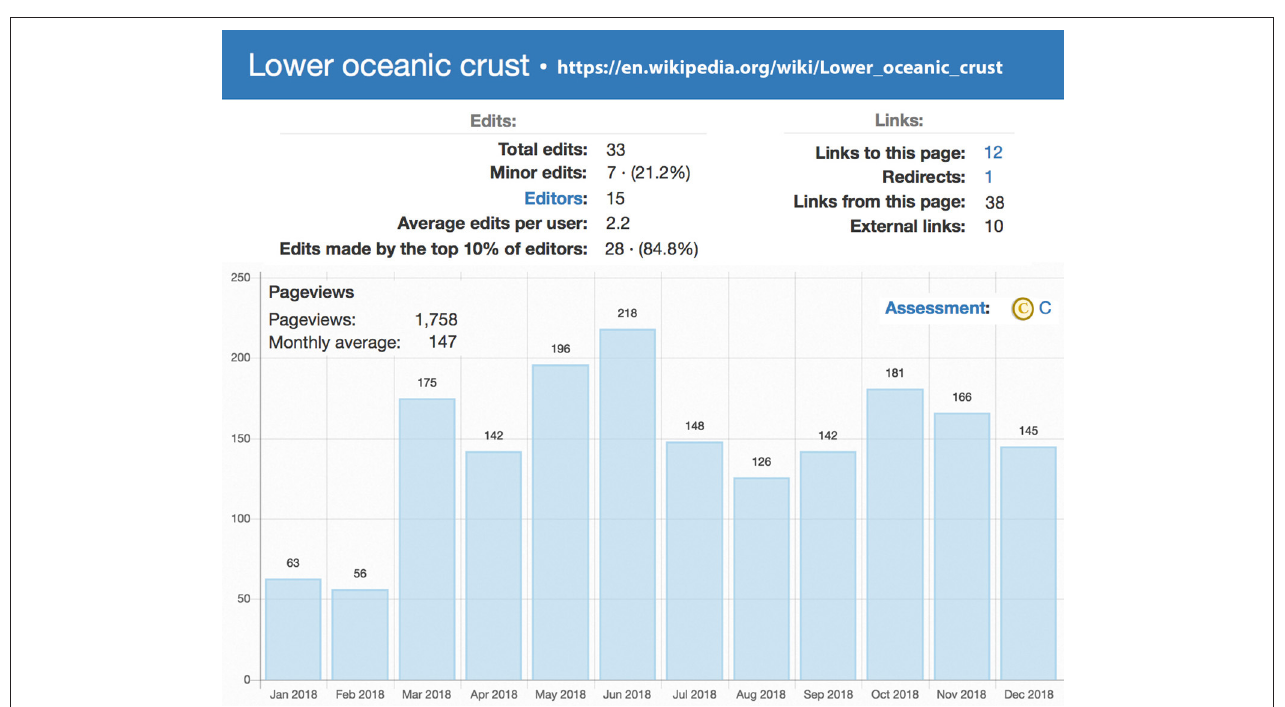
FIGURE 5 | Wikipedia statistics about the newly created page about the “Lower oceanic crust” (on 01.01.2019; 11 months after publication). https://en.wikipedia. org/wiki/Lower_oceanic_crust.